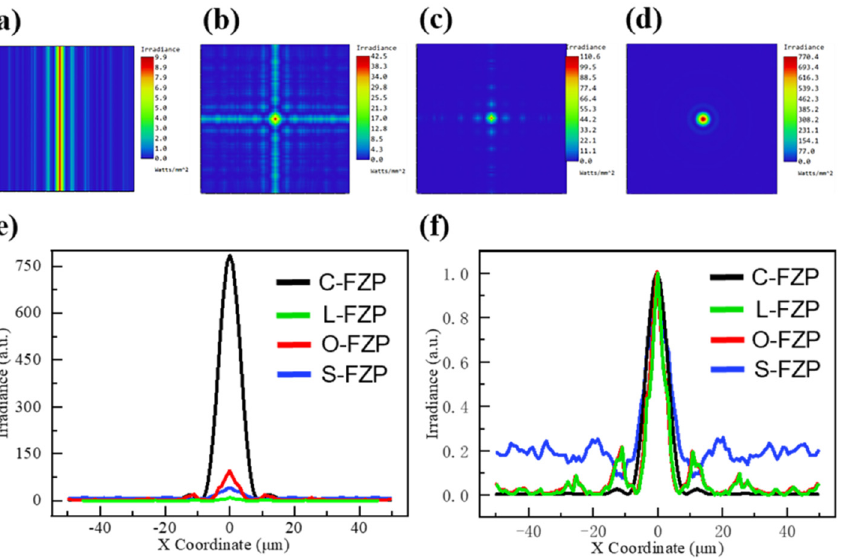
Figure 8. The focal point pattern of FZPs: ( a ) L-FZP; ( b ) S-FZP; ( c ) O-FZP; ( d ) circular FZP (C-FZP), and the corresponding contrast diagram of focal point energy of FZP: ( e ) Unnormalized graph; ( f ) normalized graph.